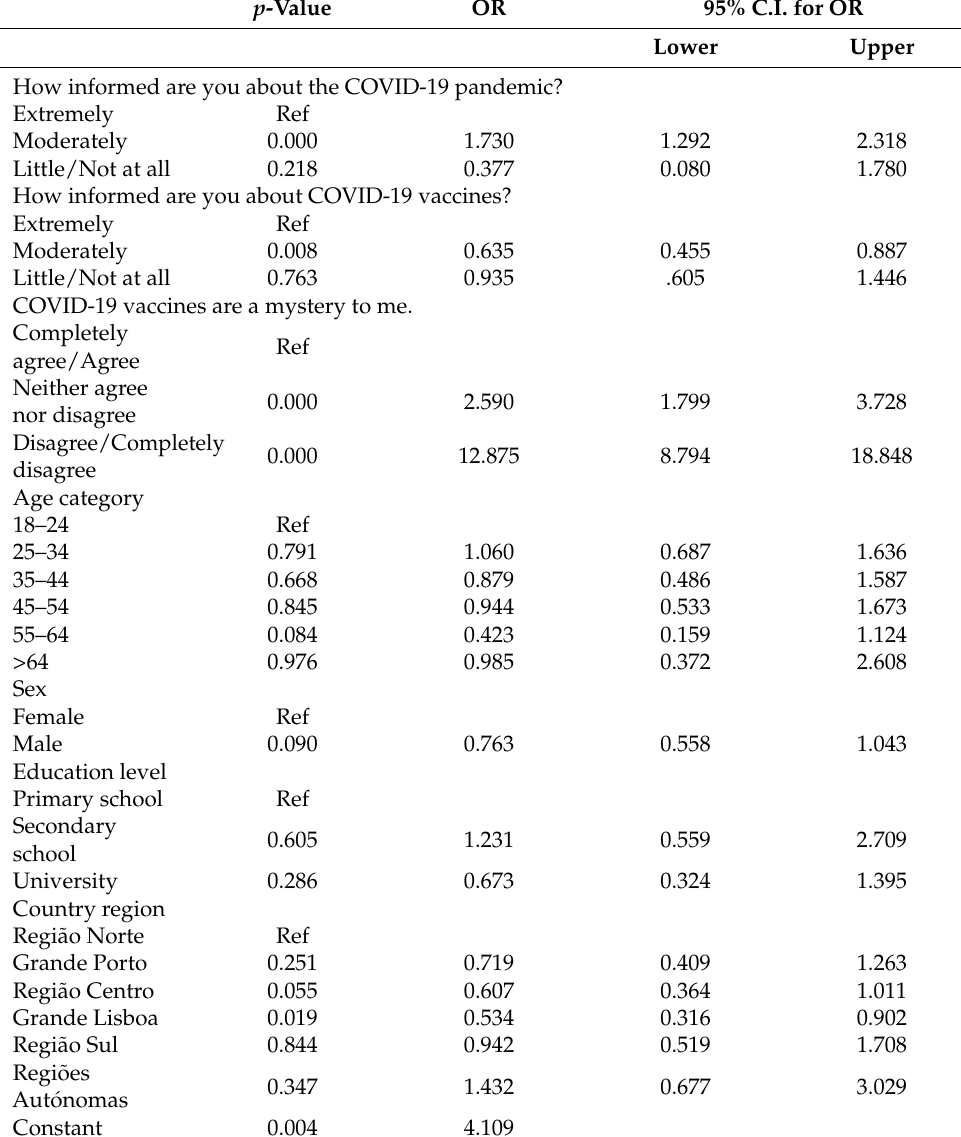
Table 4. Perceived vaccine knowledge and vaccine